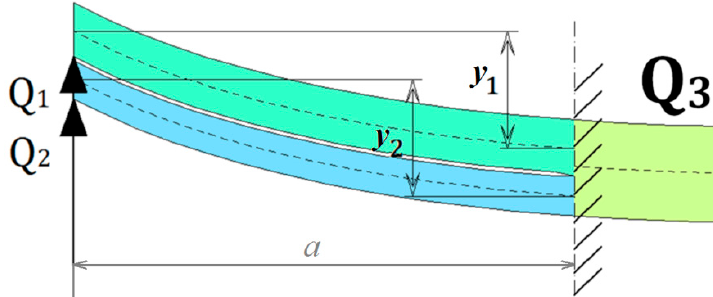
Figure 3. Assumption of equal deflection of sublaminate 1st and 2nd deflections during the AENF test.